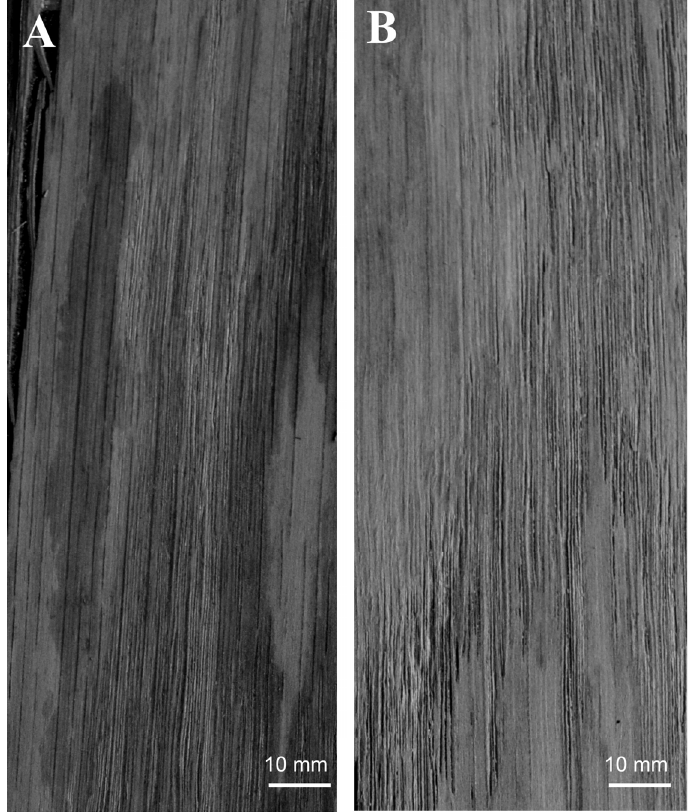
Figure 3. 0.6-mm thick oak veneer surface: ( A ) adhesive overpenetration and staining (polyurethane (PUR) without SiO 2 ), ( B ) avoided staining (PUR with SiO 2 ).